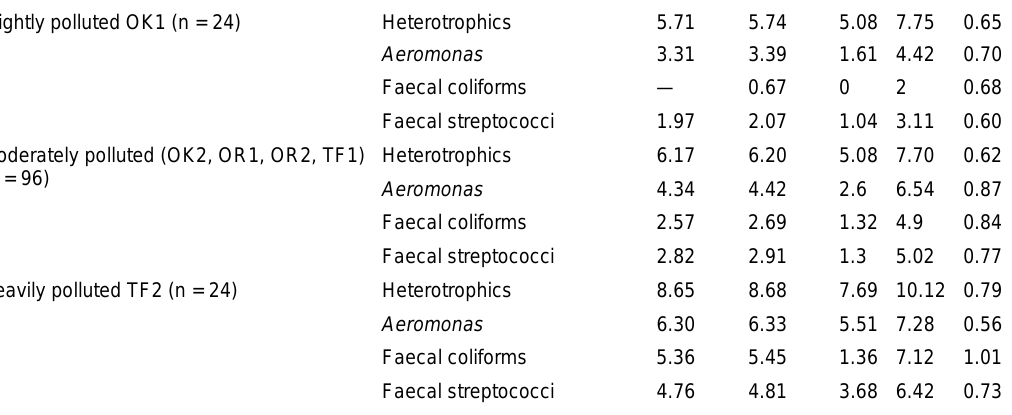
Bacteriological Counts from Each